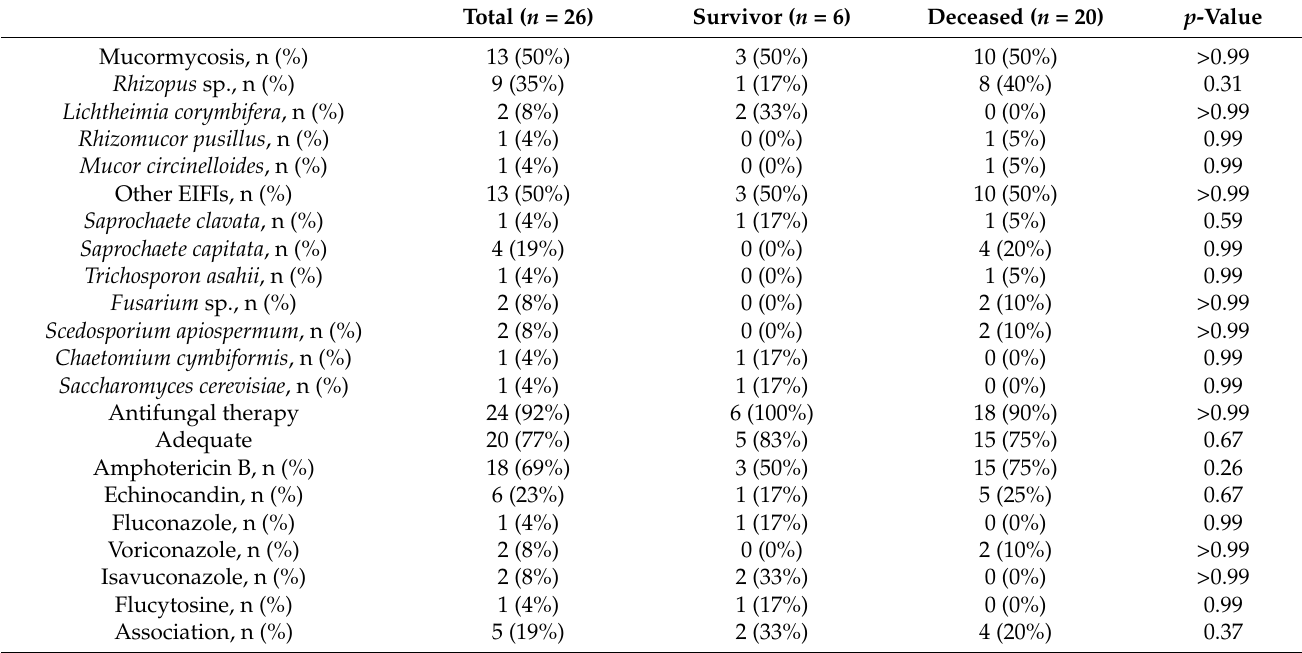
Table 2. Details on molds isolated and antifungal treatments.